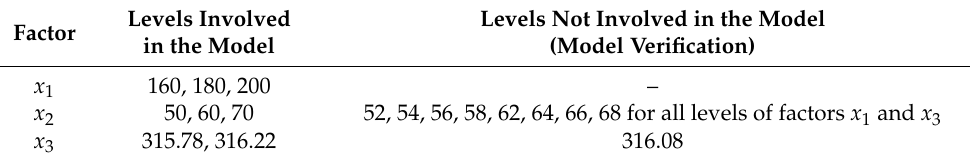
Table 6. Experiment levels and verification levels.